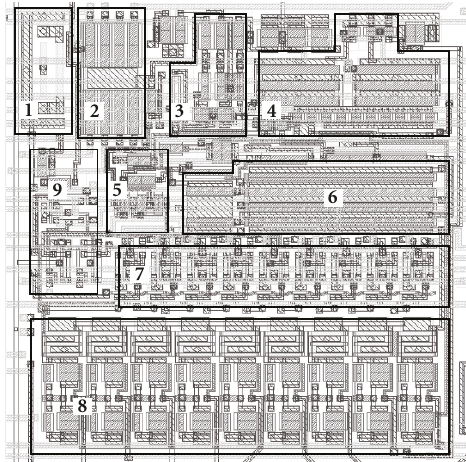
Figure 9: Layout of the pixel cell